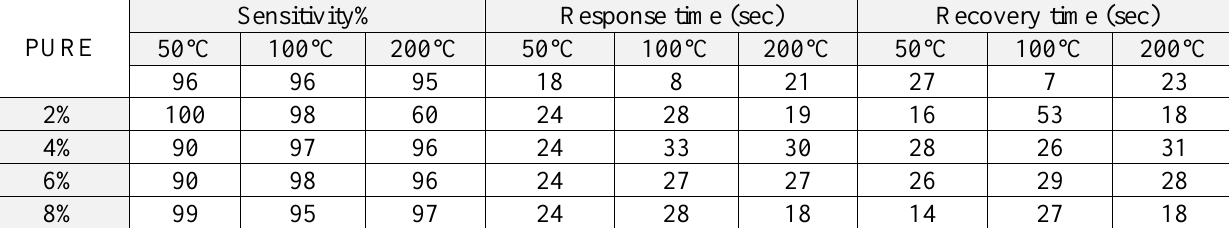
Table 2: The sensitivity, response and recovery